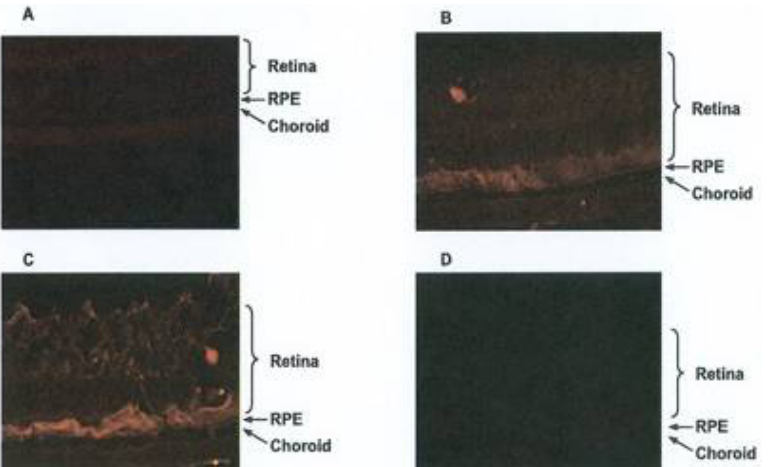
Figure 6. Mice were injected with 2 uL [2 × 10 6 encapsidated genomes] of AAV encoding APNp1 and then lasered to induce CNV. Mice were sacrificed on days 4 ( A ), 14 ( B ), and 28 ( C ) post laser. Control mice were injected with AAV.Neo [2 × 10 6 encapsidated genomes] and sacrificed on day 28 ( D ).